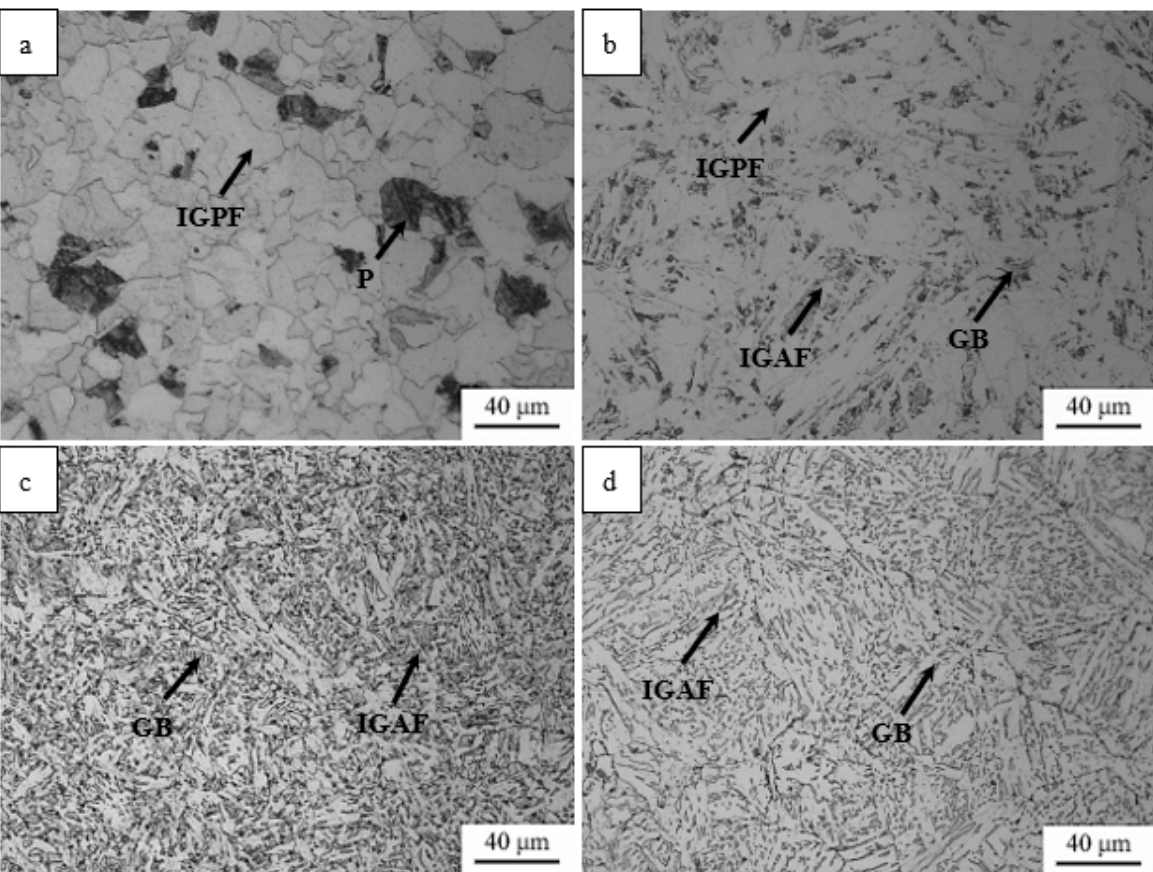
Figure 4. Optical micrographs of the simulated samples of ( a ) 120 kJ/cm, ( b ) 85 kJ/cm, ( c ) 65 kJ/cm, and ( d ) 35 kJ/cm.